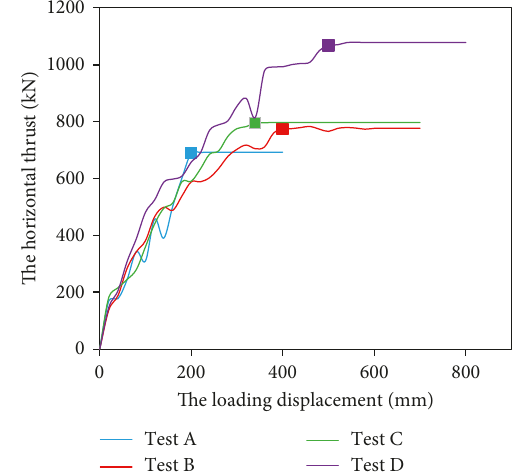
Figure 10: Variation ofsoilpressure withinstallmentdepth for Test B.